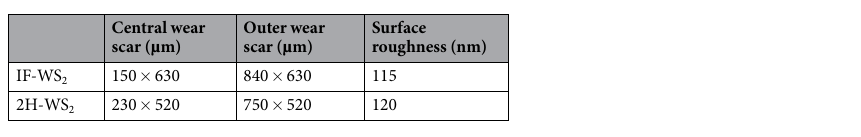
Table 7. Physical properties of the wear scars on the ball specimens tested at 100